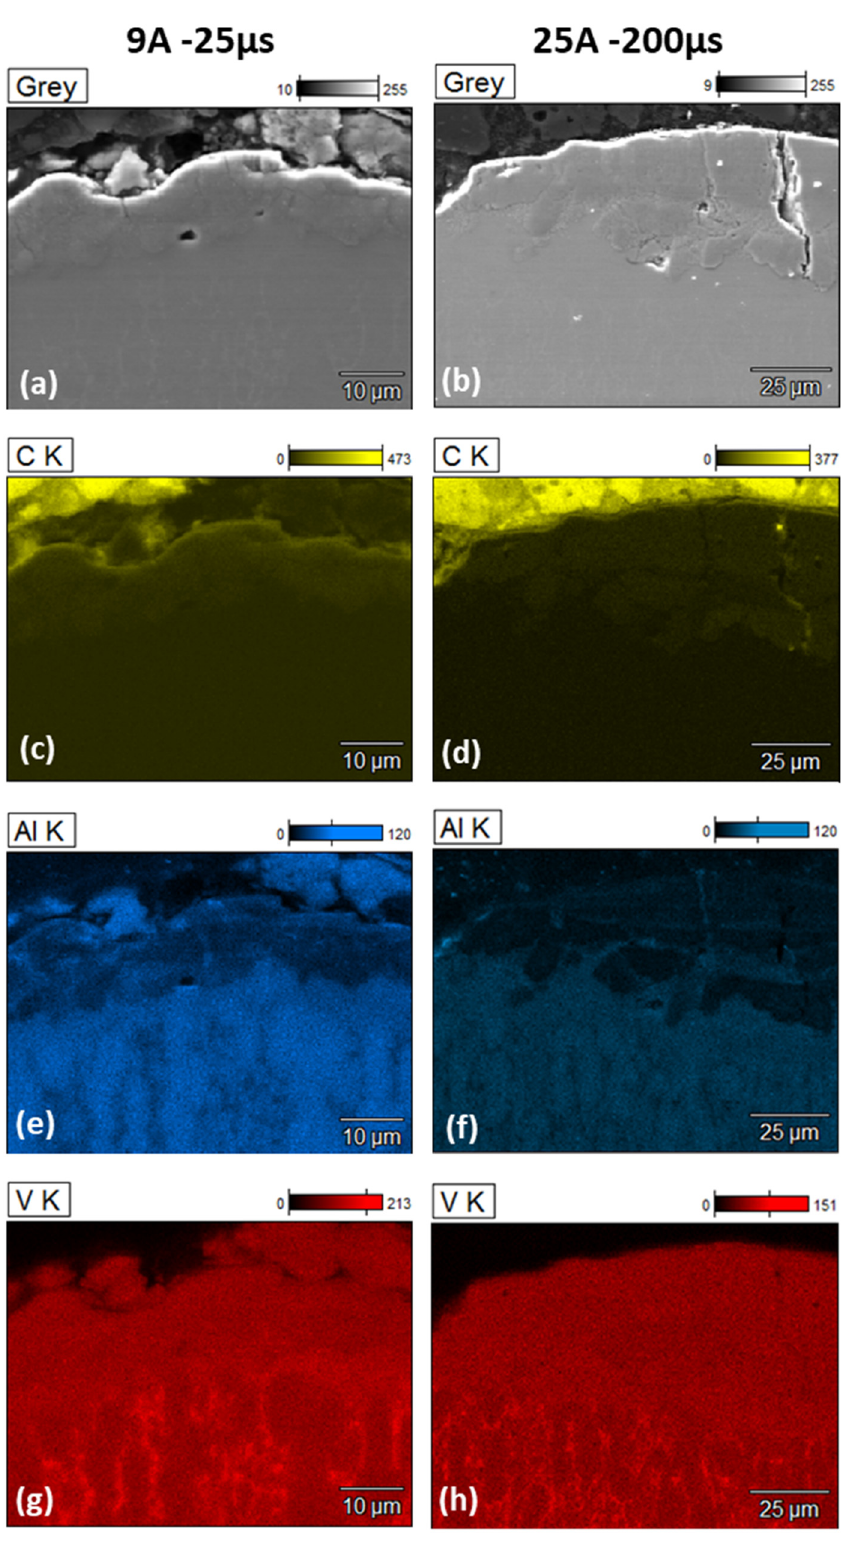
Figure 13. EDX chemical composition maps for 2 different machining conditions. For ( a , c , e , g ) 9 A— 25 µs, and ( b , d , f , h ) 25 A—200 µs machining conditions. Yellow signals indicate the localization of carbon ( c , d ), blue signals indicate the localization of aluminum element ( e , f ), and red signals indicate the localization of vanadium element ( g , h ).